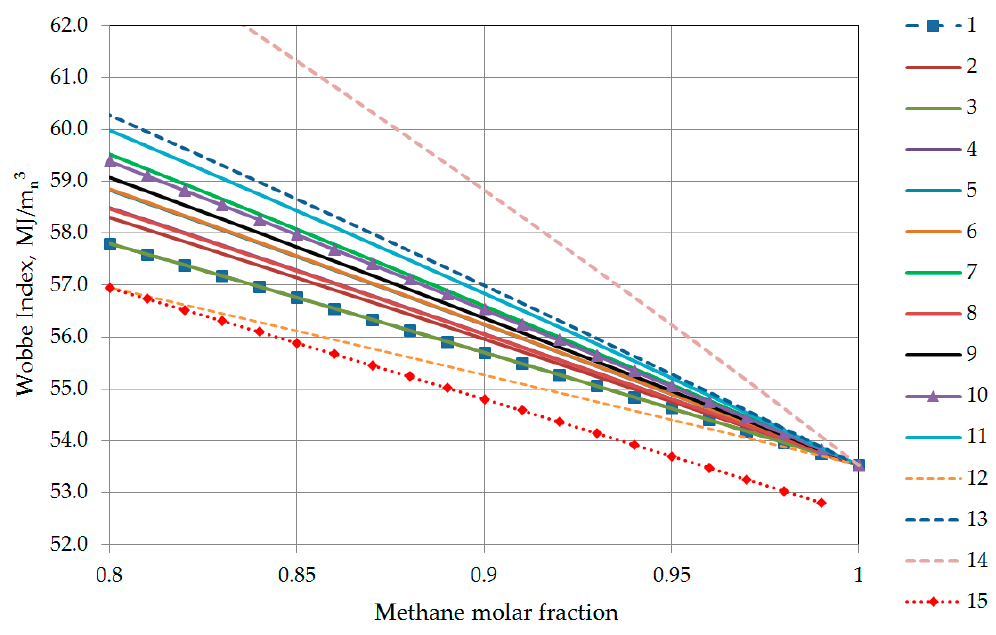
Figure 9. Wobbe Index as a function of methane molar fraction for tested sets of LNG compositions.